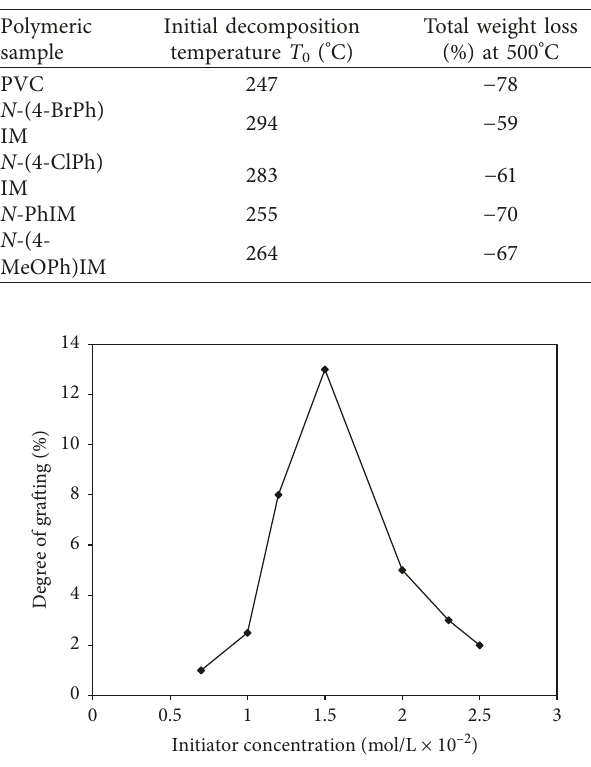
Table 3: Initial decomposition ( T 0 ) and total weight loss per- centage at 500 ° C of PVC and modified PVC by various itaconimide derivatives, under the nitrogen atmosphere.